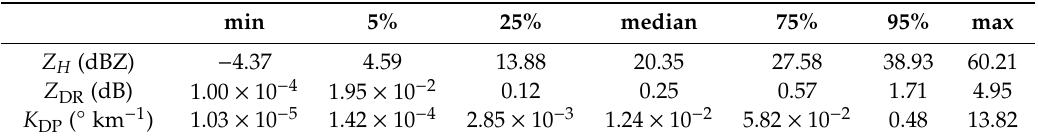
Table 3. The quantiles of polarization radar variables derived from DSDs using the T -matrix scattering method.